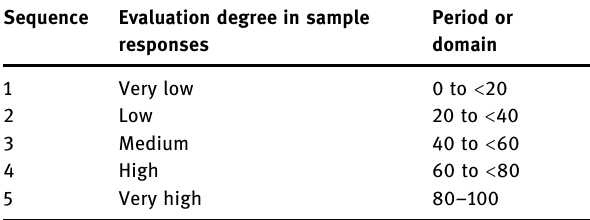
Table 2: Weighted value for importance degree in